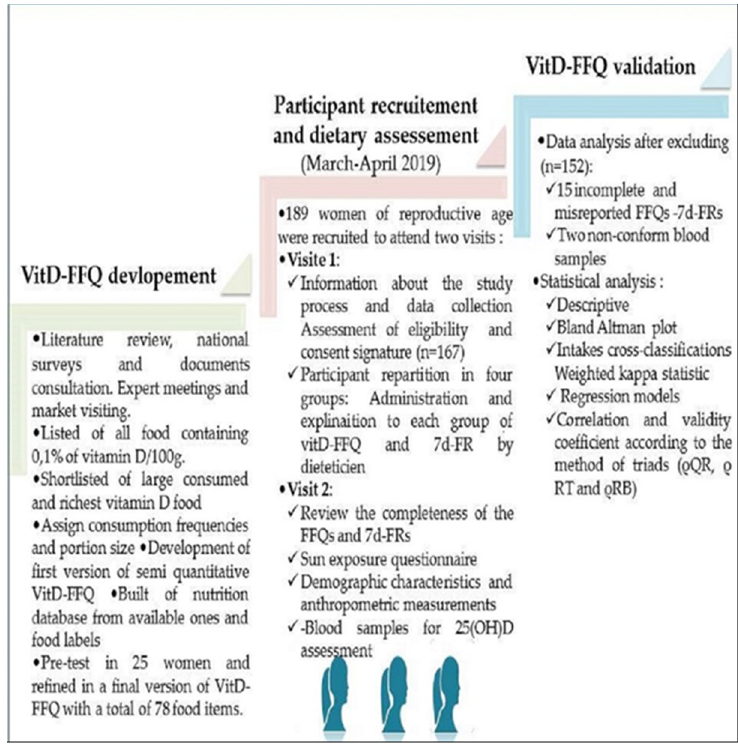
Figure 1. The development and validation process algorithm of the VitD-FFQ.